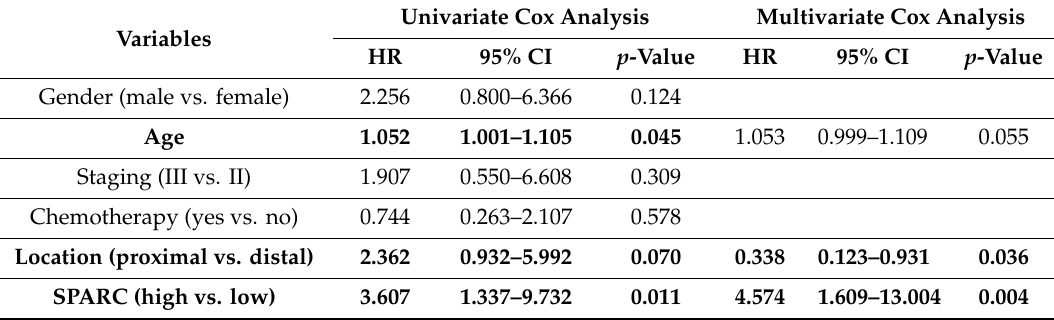
Table 2. Variables a ff ecting 5-year OS in patients of the tissue microarray cohort with recurrent